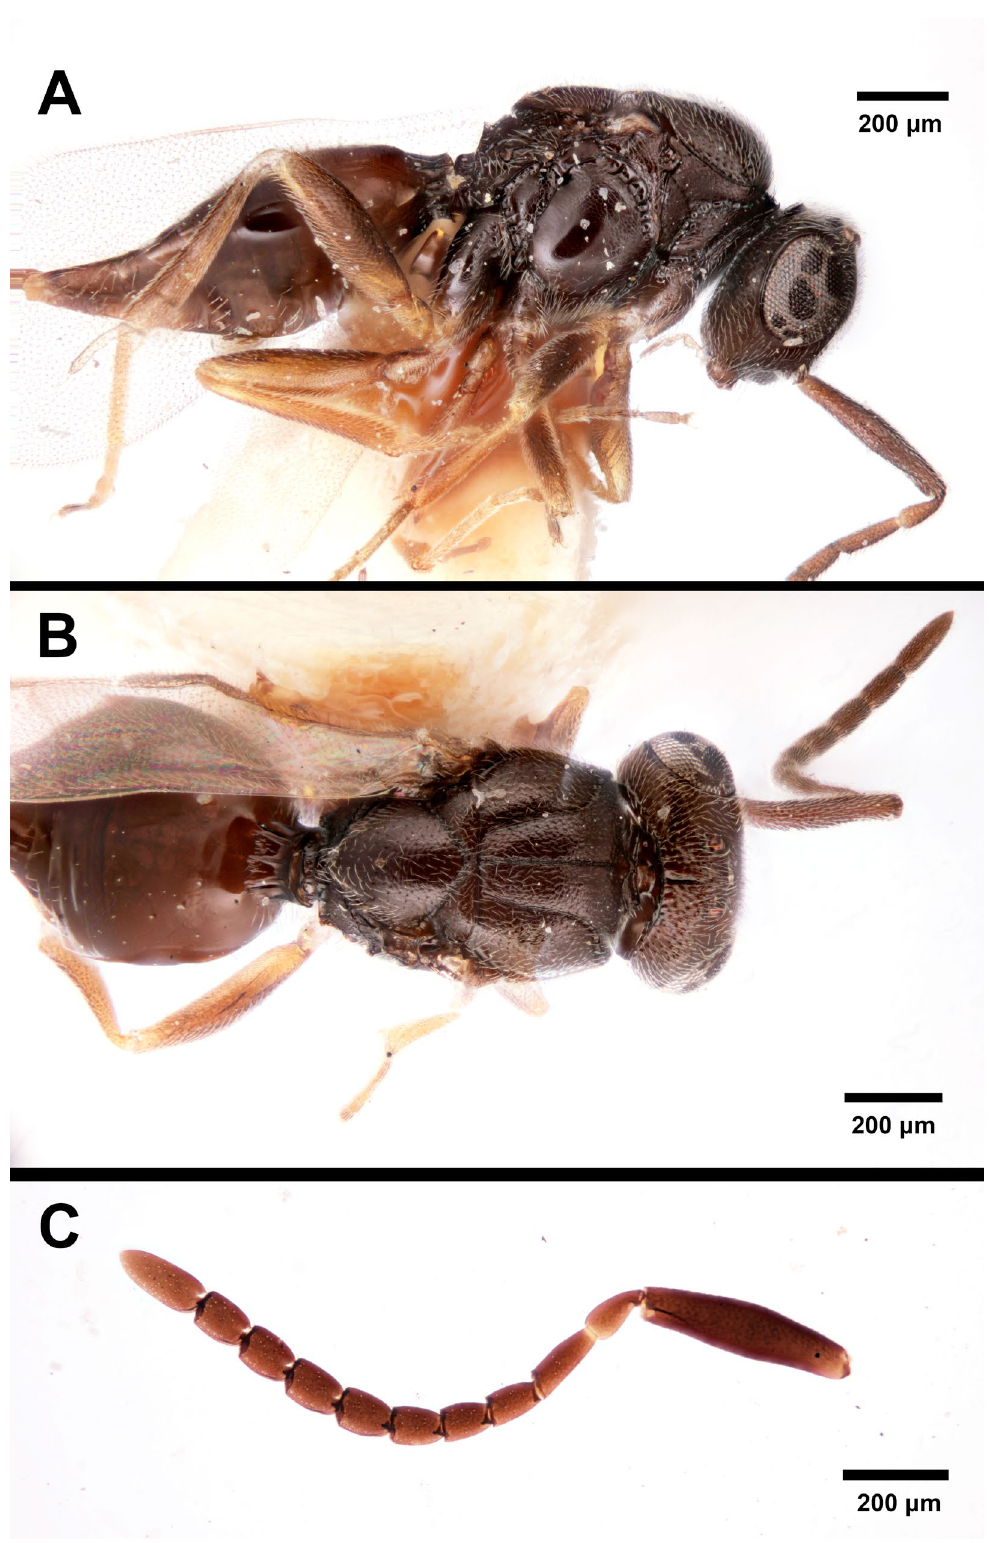
Fig. 25. Dendrocerus remaudierei Dessart, 1974, allotype, ♀. A . Lateral habitus (MNhN EY25336). B . Dorsal habitus (MNhN EY25336). C . Lateral view of the right antenna (MNhN